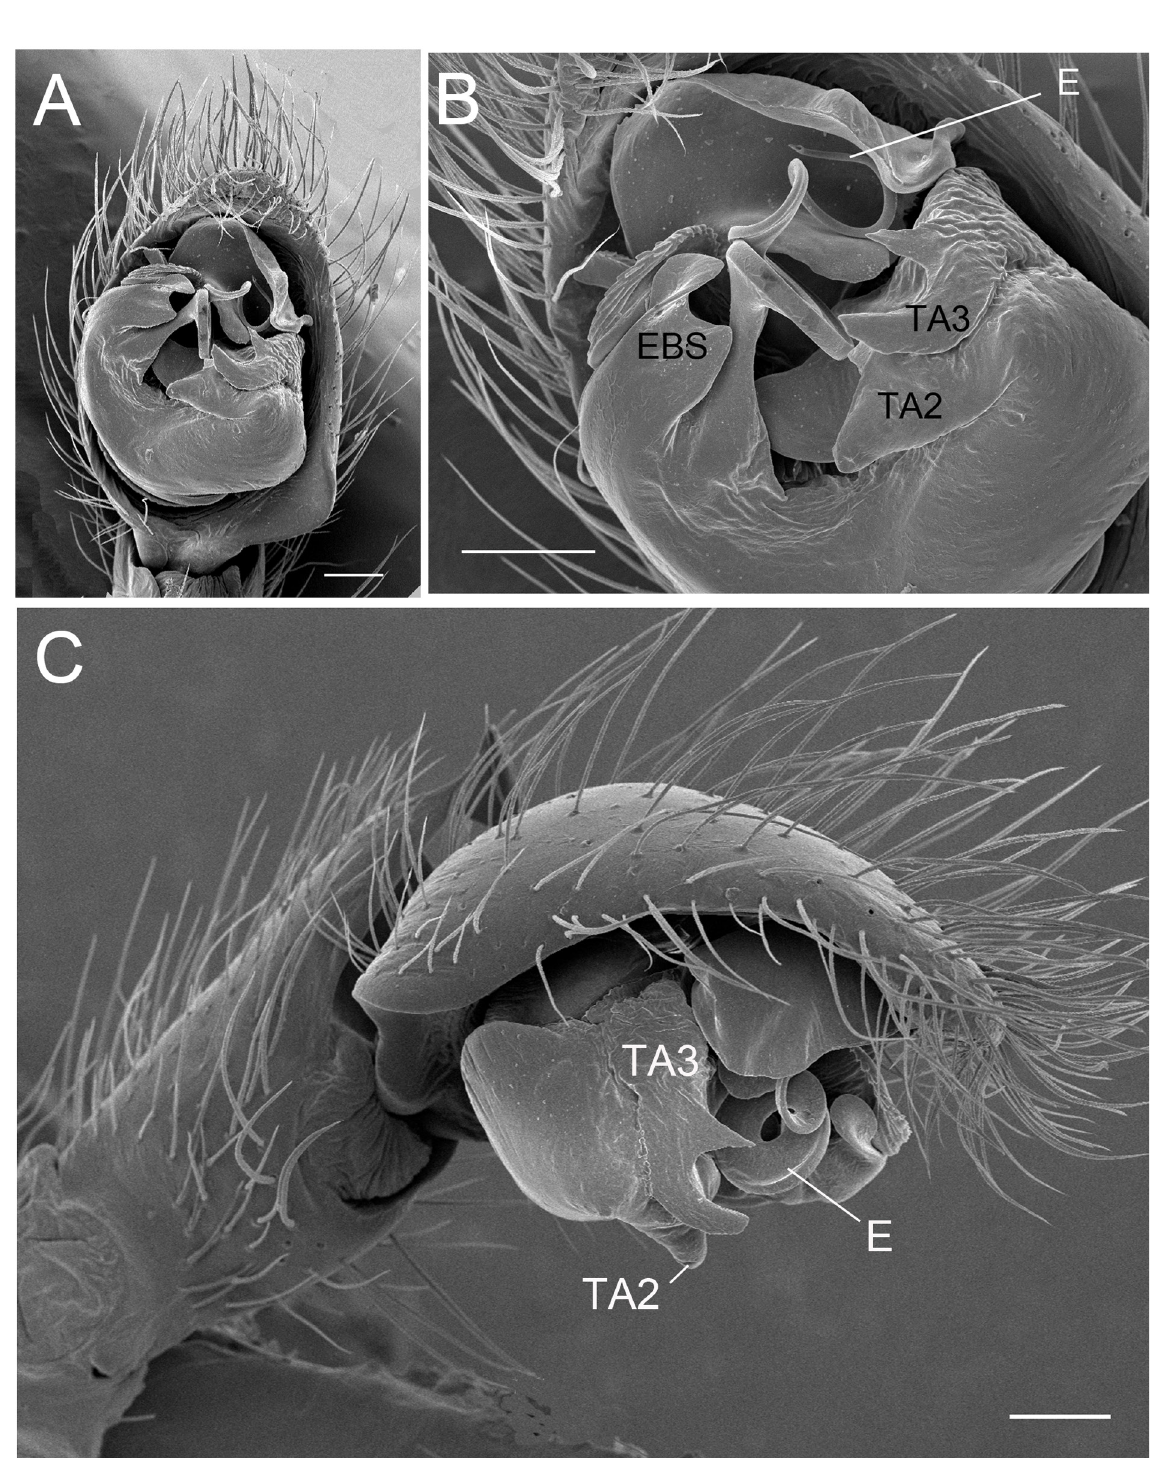
Fig. 2. Xevioso cepfi sp. nov., ♂, paratype (RMCA_ARA_245487). A . Palp, ventral view. B . Palp, as preceding, detail. C . Palp, retrolateral view. Abbreviations: EBS = basal embolic sclerite; E = embolus; TA2, TA3 = tegular apophyses 2 and 3. Scale bars = 100